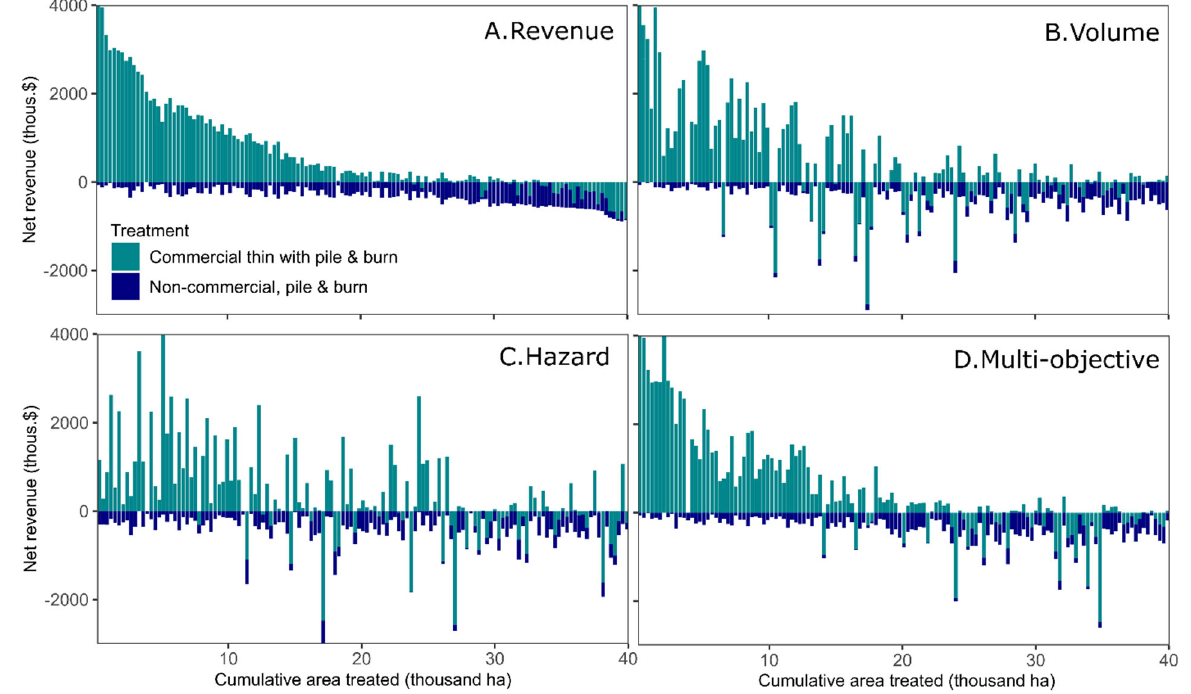
Figure 5. Treatment prescriptions within projects with 300 ha of treated area scheduled for four scenarios: max net revenue, max volume, max hazard, and multi ‐ objective.